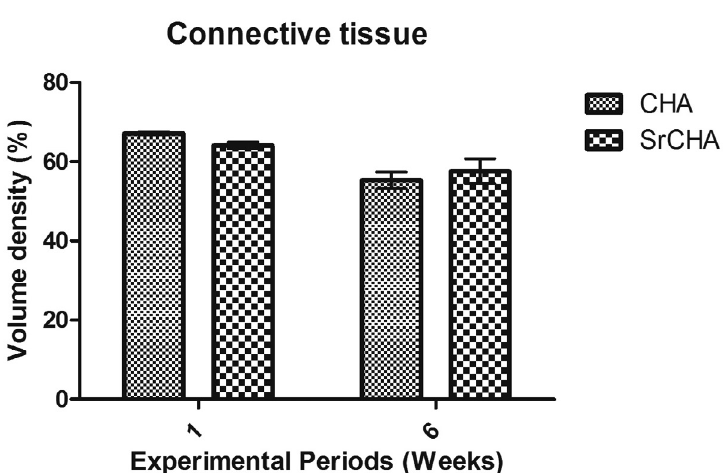
Figure 6- Volume density of connective tissue in the tooth socket after 1 and 6 weeks of implantation. The values were similar for both groups in both experimental periods. We observed no significant difference between groups. Results are shown as mean percentages ± confidence interval (vertical